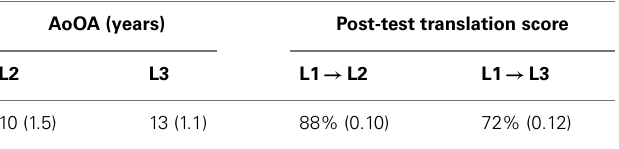
Table 2 | Summary of participants’ estimated age of onset of acquisition (AoOA) of L2 and L3 and post-test translation scores